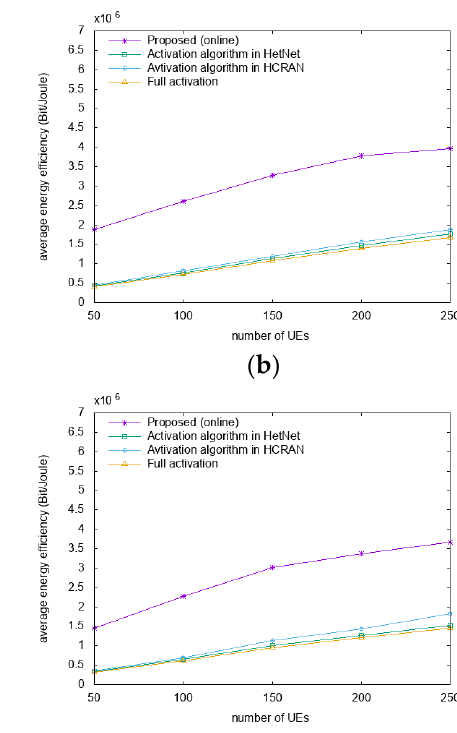
Figure 5. Comparison of the energy efficiencies. ( a ) 2x and ( c) 4x speeds with Gaussian distributions; ( b ) 2x and ( d ) 4x speeds with uniform distributions.